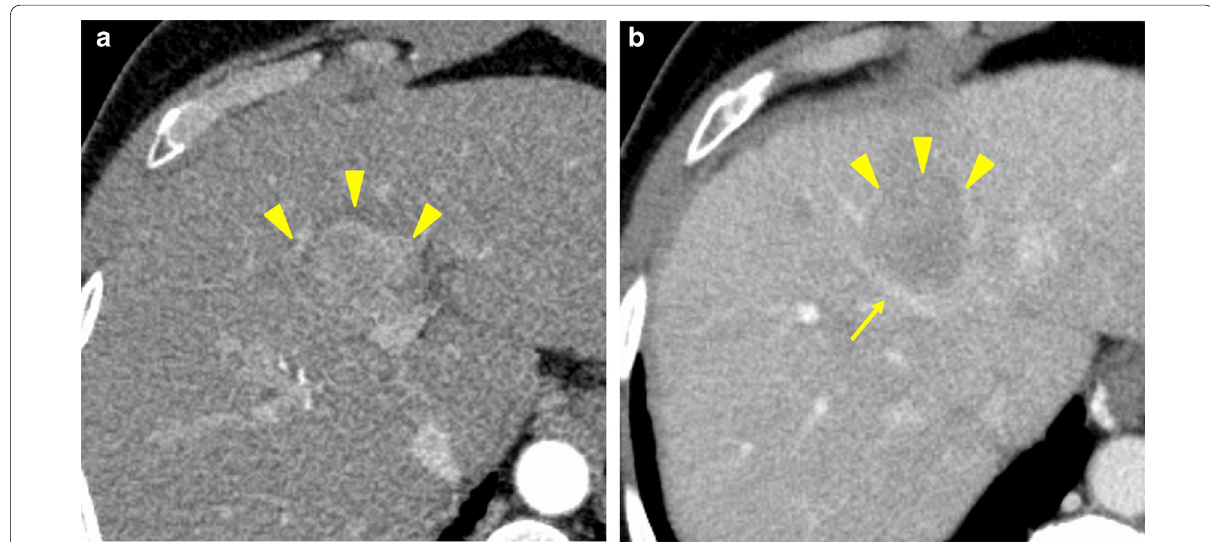
Fig. 1 Preoperative contrast-enhanced computed tomography image of the liver. The tumor was located in the medial section of the liver (arrowheads) and showed heterogeneous enhancement in the arterial phase ( a ) and washout in the portal venous phase ( b ). The arrow indicates the middle hepatic vein